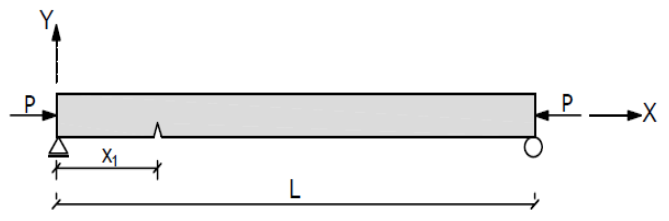
Fig. 1. Beam with a single crack subjected to axial force